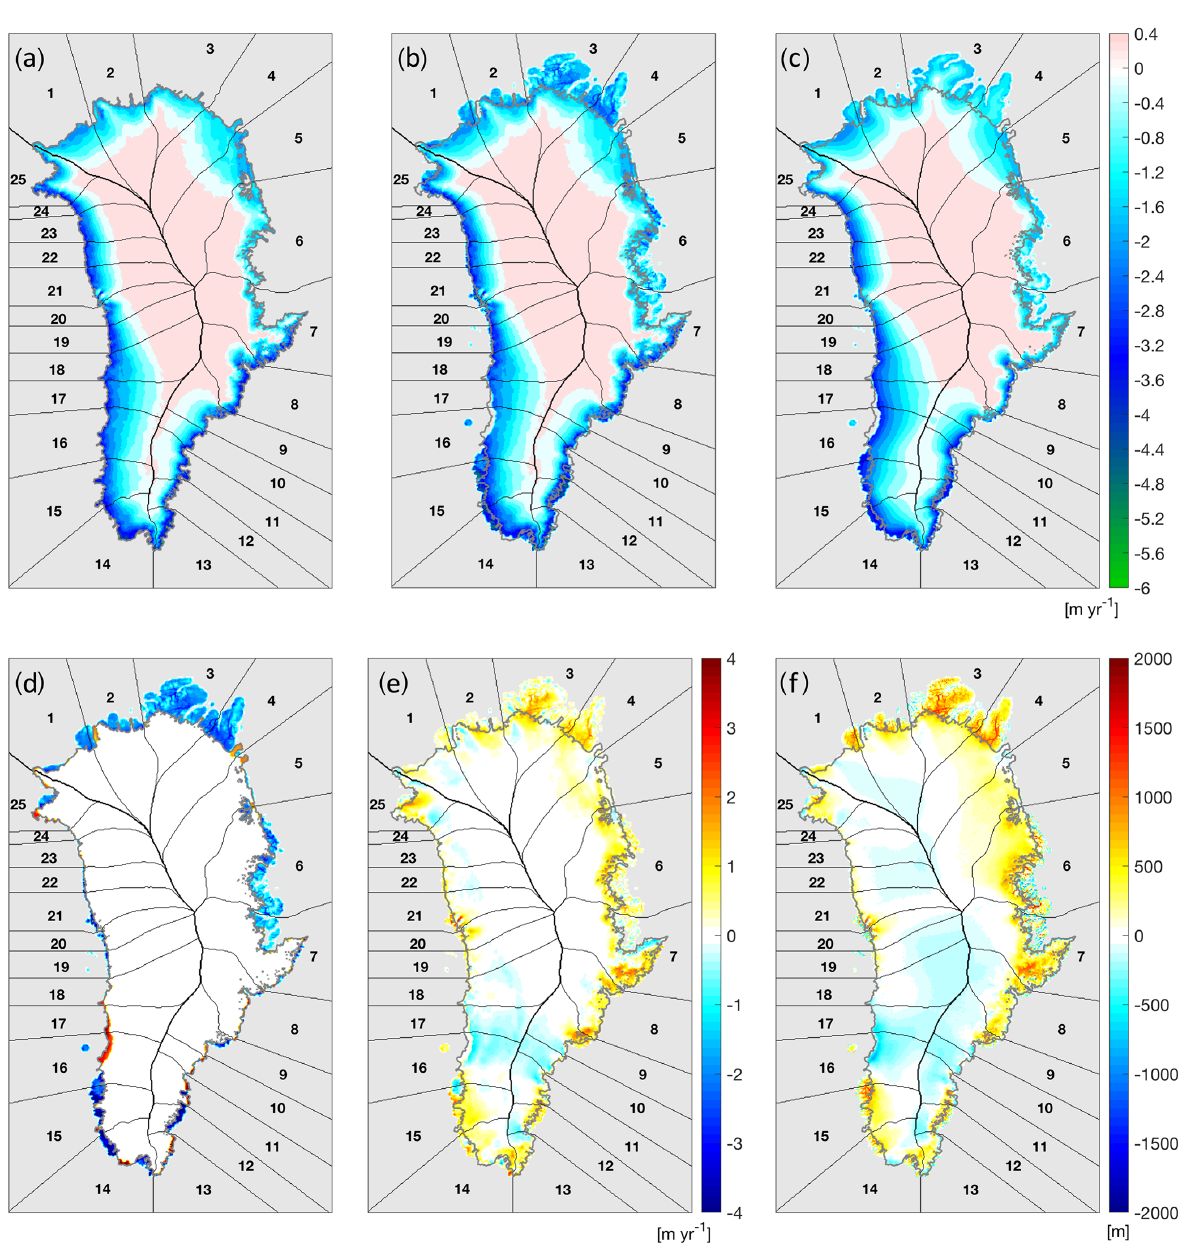
Figure 7. (a) SMB anomaly from the RCM MAR (same as Fig. 5a), (b) extended to the VUB_GISM initial geometry using the method of Franco at al. (2012) and (c) remapped with weighting between neighbouring basins for the same geometry. The differences between (b) and (a) are shown in (d) and the differences between (c) and (b) in (e) . The model bias in surface elevation is shown in (f) . The grey lines mark the observed ice sheet